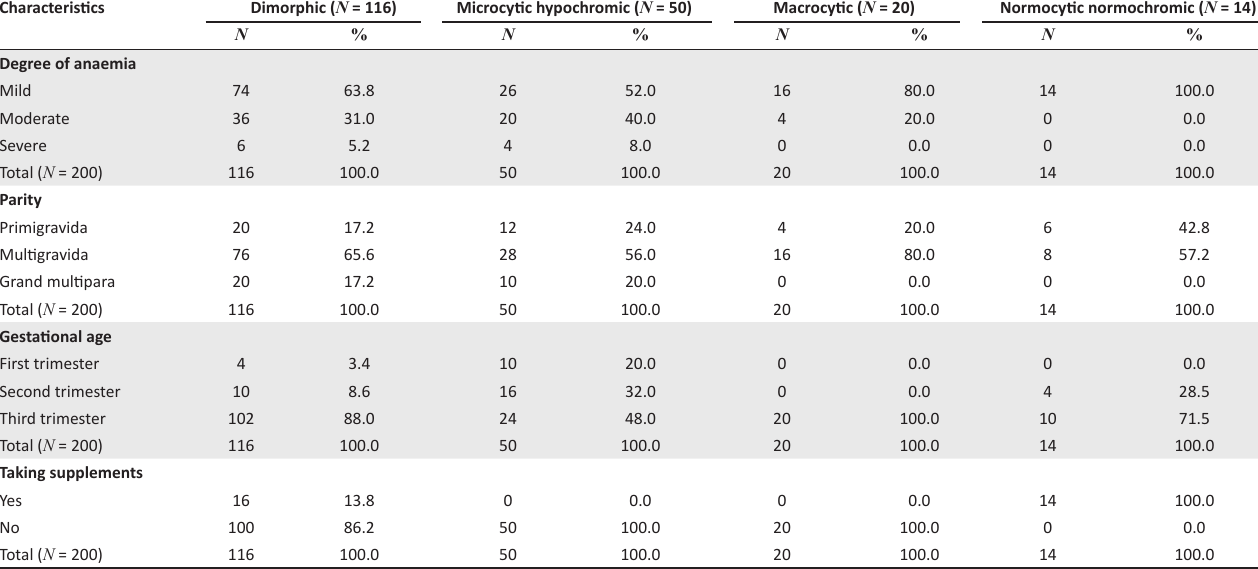
TABLE 2: Morphological patterns of anaemia across participant characteristics, Sudan, September 2016 to February 2017. Characteristics